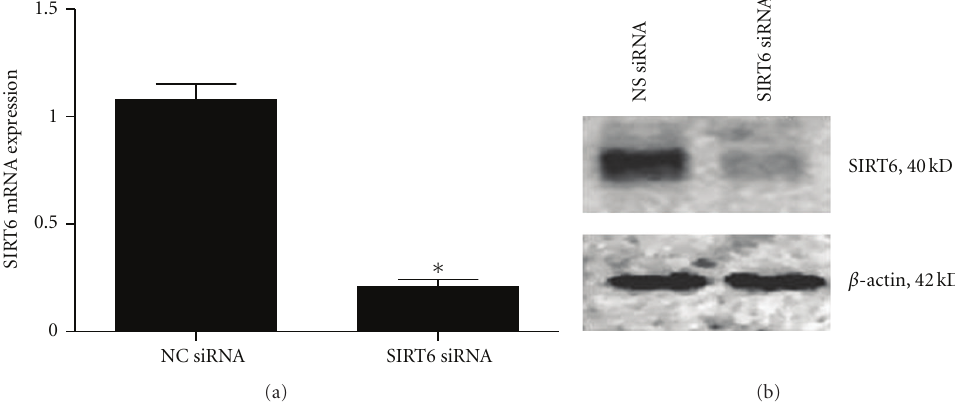
Figure 2: E ffi ciency of SIRT6 siRNA transfection. HUVECs were transfected with 50nM SIRT6 or NS siRNA for 96h ( n = 6). (a) SIRT6 mRNA expression was quantified by qRT-PCR. SIRT6 expression is displayed as mean ± SEM. ∗ P < 0 . 05 versus NS siRNA transfected cells. (b) SIRT6 protein was assessed by Western blotting. One representative image is